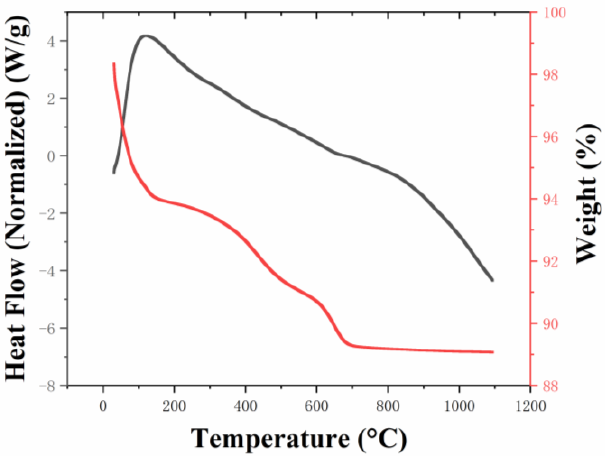
− TG curve of mixture of MGS Sintered Figure 20. DSC−TG curve of mixture of MG S Sintered Brick. Figure 20. DSC